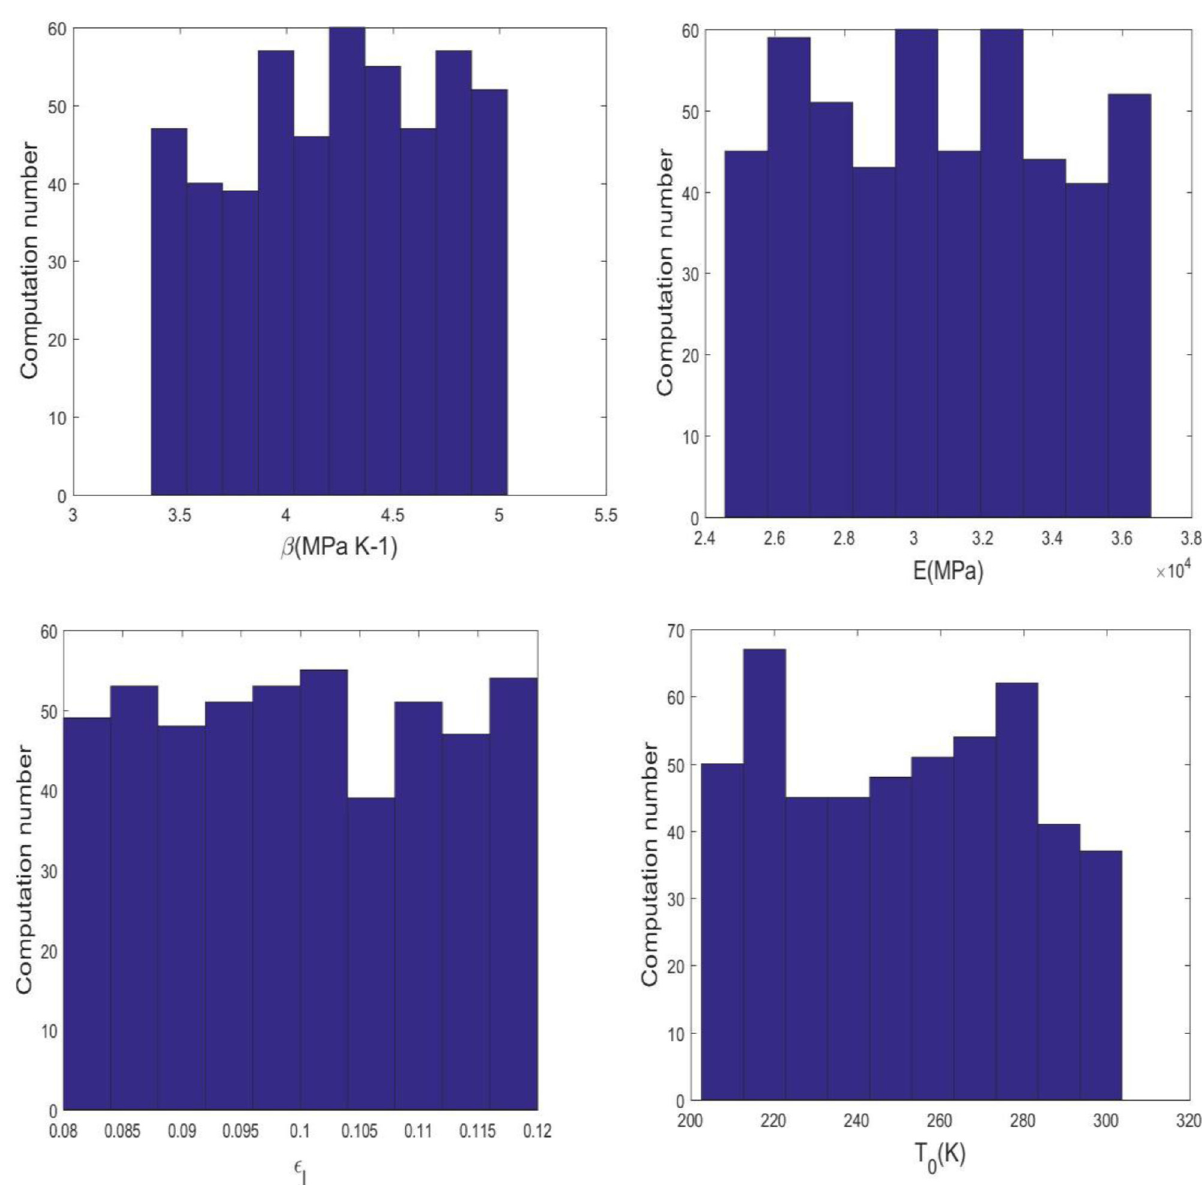
Fig. 9. Probability distribution of the inputs. a: the Young ’ s modulus E; b: the temperature scaling parameter b ; c: the reference temperature T 0 ; d: the maximum transformation strain Ɛ l .